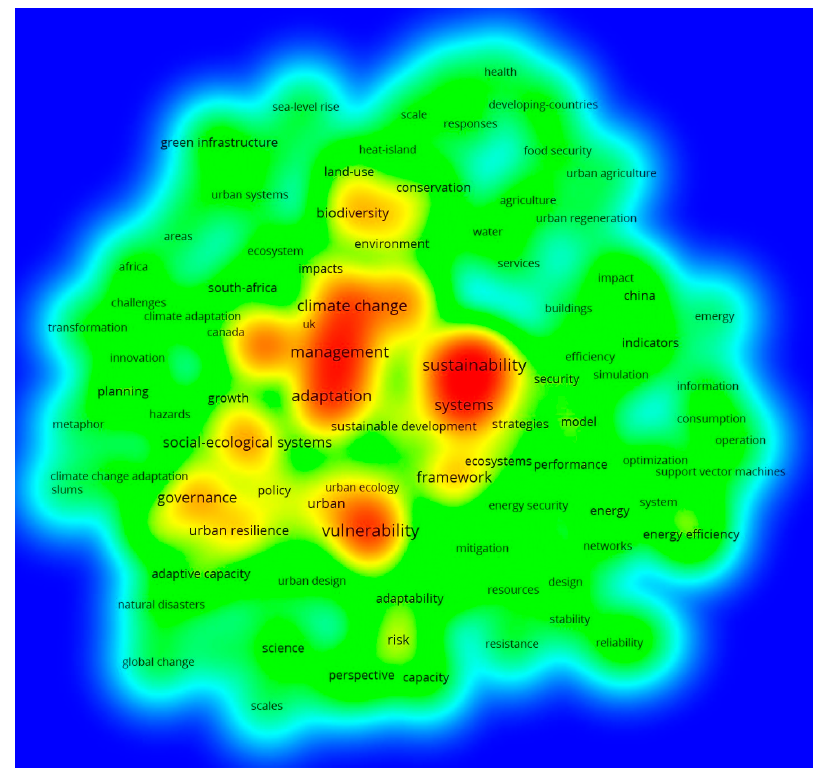
Figure 2. Keywords co-occurrence map (by linkage), showing the relationship between research areas.